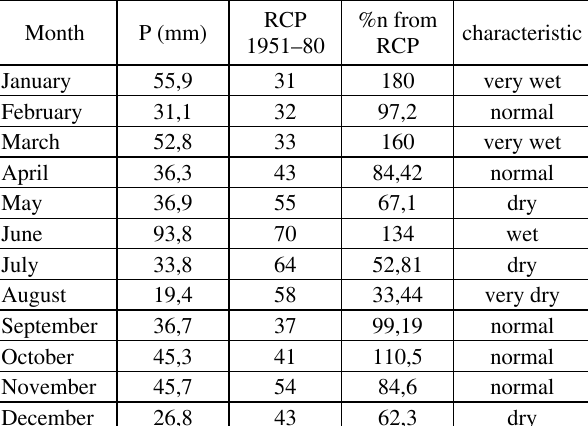
Table 3 . Evaluation of months according to rain reference cli-